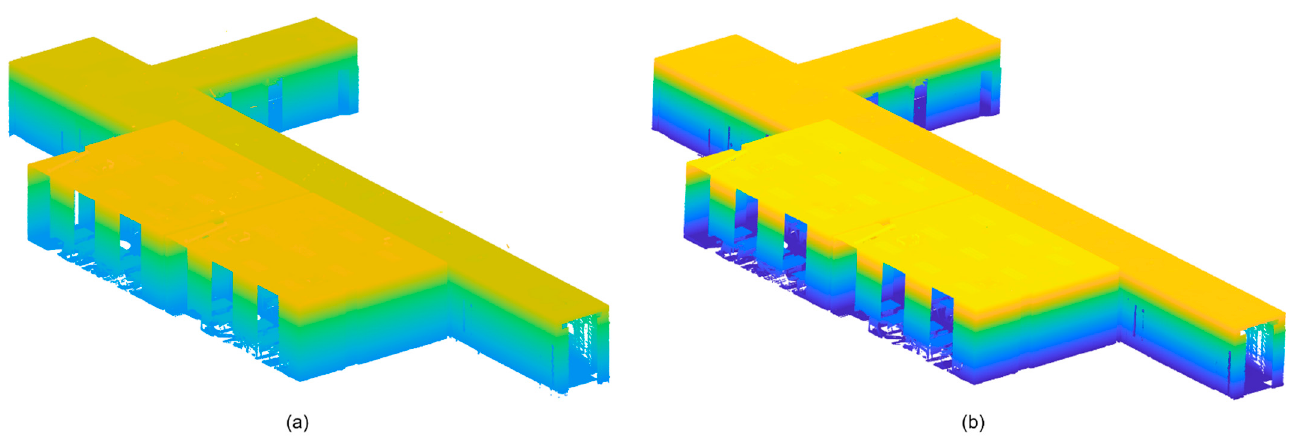
Figure 7. The three-dimensional view of the indoor data points selected for dataset 1: ( a ) using the data projection to xy plane, ( b ) using the data obtained in ( a ) and projected to the yz plane.